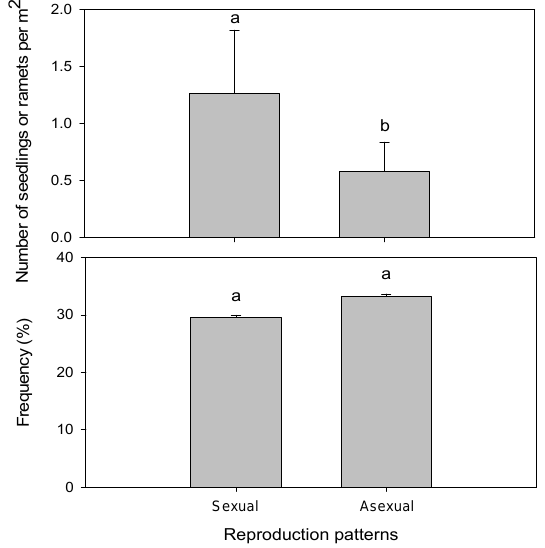
Figure 2. Density (number of surviving either seedlings (sexual re- production) or ramets (asexual reproduction) per m 2 ) and frequency (%) coming from either sexual or asexual reproduction in the shrub A. wudanica . Histograms show the mean ± 1 SE of n = 27. Differ- ent letters above the histograms indicate significant differences at p